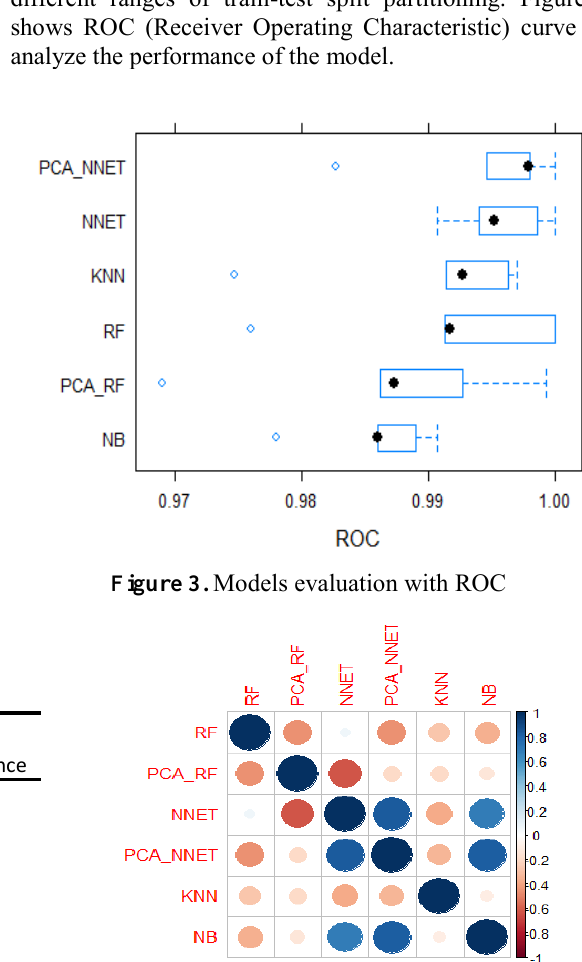
Table 2. Confusion matrix for proposed model